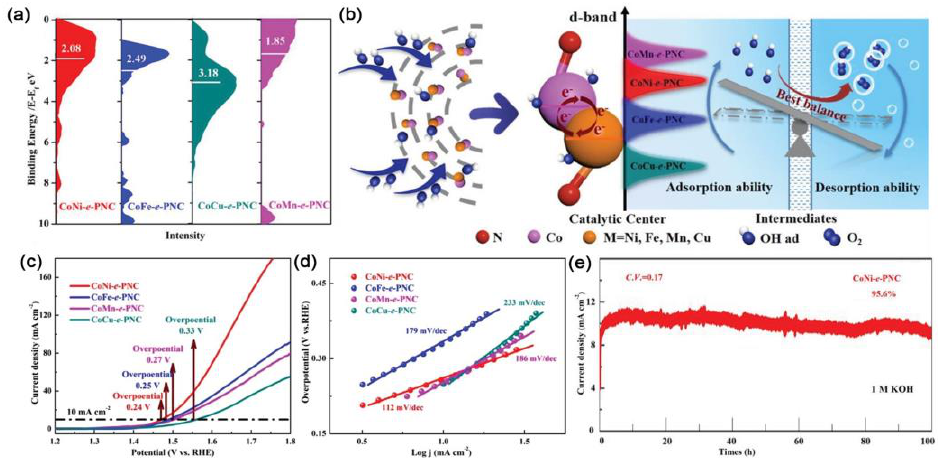
Figure 12. ( a ) Valence band spectra (the white bar shows d-band center). ( b ) Schematic illustration for the OER reaction process of CoM − e − PNC catalysts. ( c ) Polarization curves. ( d ) Tafel plots. ( e ) i − t curves obtained at 10 mA cm − 2 for CoNi − e − PNC catalyst. Reproduced with permission from ref. [120]. Copyright 2019, Wiley-VCH.